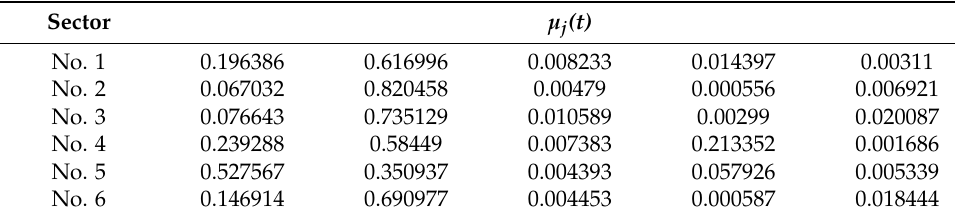
Table 5. Parameters of the indicators change rate µ j ( t ) (author’s results).